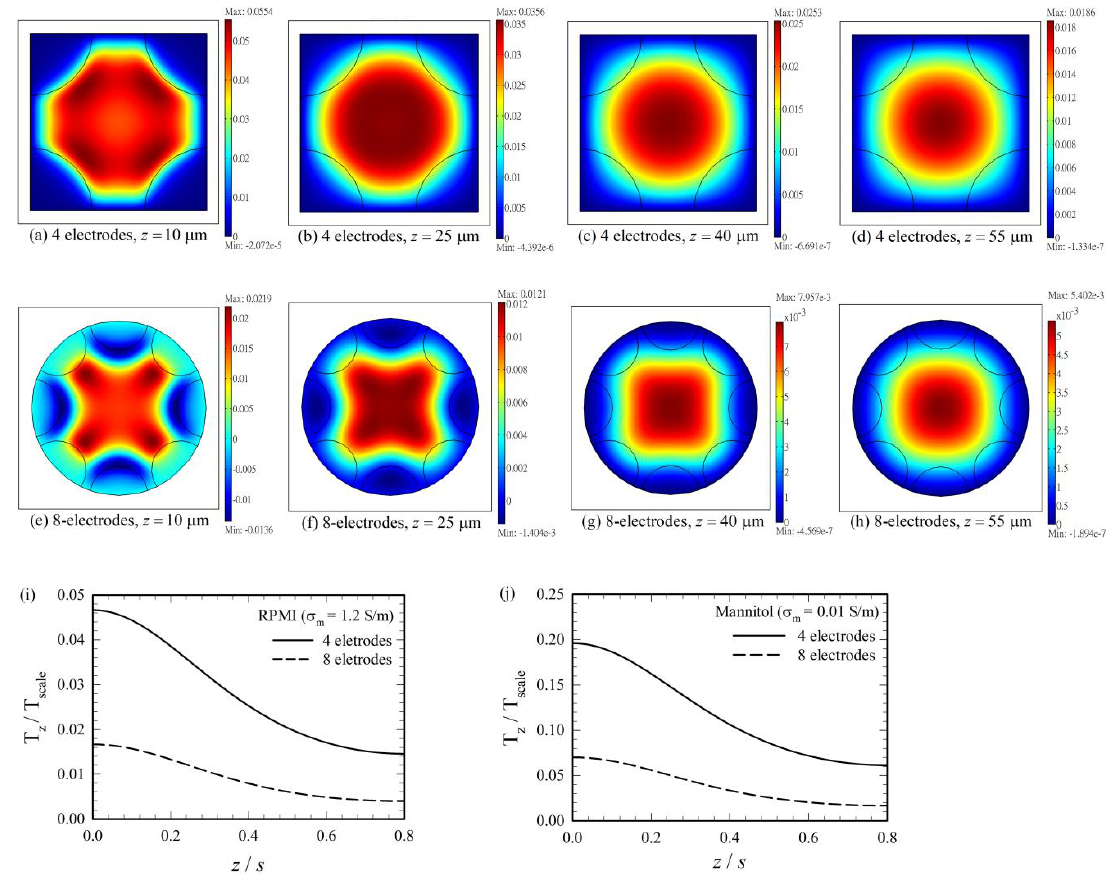
Figure 5. ( a–d ) Distributions of the vertical (z-component) dimensionless DEP torque, (cid:101) T z (= T z /T scale ) , on horizontal planes at di ff erent heights of the four-electrode system for the negative DEP case in Figure 2, where T scale = 4 πε m R 3 V 2 /s 2 . ( e–h ) Same as (a–d), but for the eight-electrode system. ( i ) and ( j ) Distributions of T z /T scale along the vertical axis of the ER chamber for the negative DEP case in Figure 2 and the positive DEP case in Figure 3, respectively. The tip-to-tip electrode spacing s = 100 µ m.